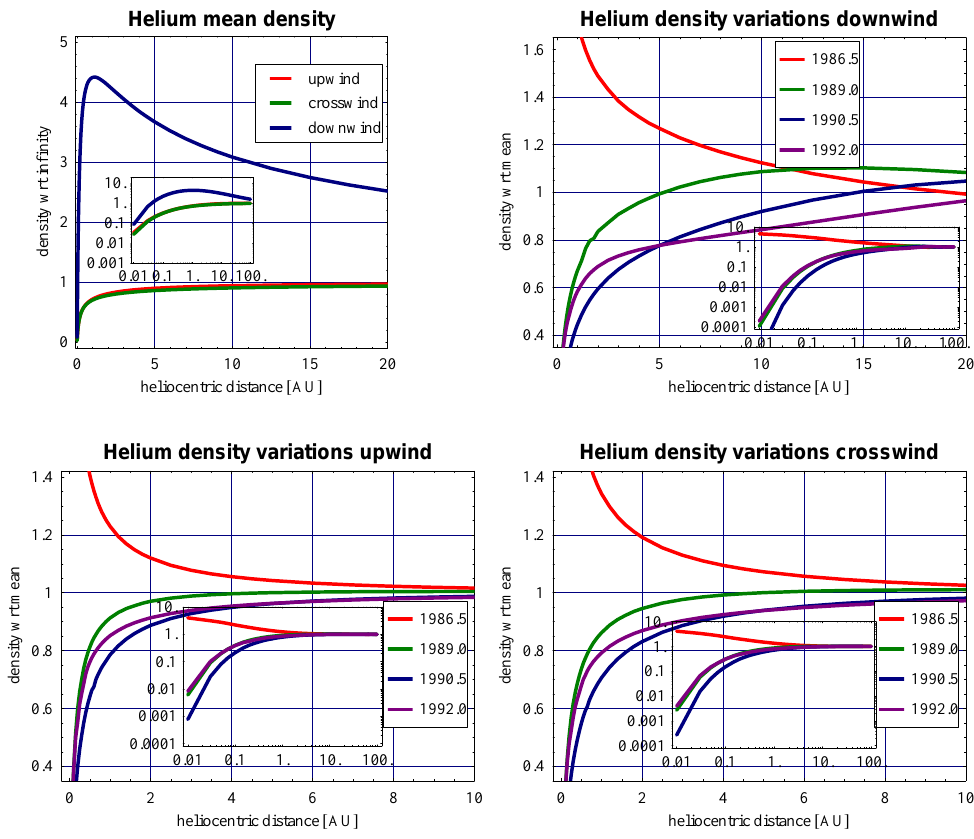
Fig. 3. Evolution of helium density during the solar cycle. Upper left panel: mean density along the upwind, crosswind and downwind directions, shown as a fraction of the density at infinity. The other three panels: relative departures of the density from the mean value presented in the upper left panel, shown along the upwind (lower left panel), crosswind (lower right panel) and downwind (upper right panel) directions close to the Sun for selected epochs during the solar cycle. The epochs are indicated in the boxes inside the panels. Insets show the same qunatities but presented in the log-log scale for the whole range of helicoentric distances from 0.01 to 100 AU from the